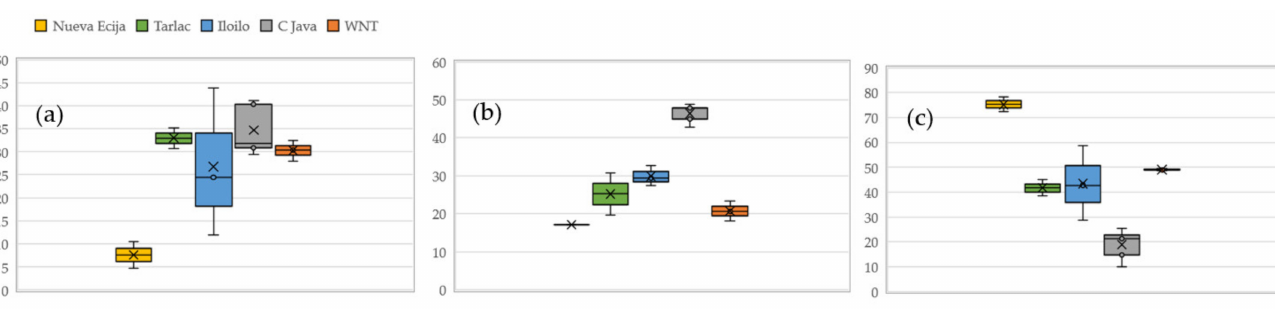
Figure 1. Characteristics of local weather in the target areas: ( a ) rainfall (mm), ( b ) minimum air temperature, ( c ) maximum air temperature and ( d ) wind speed. The x-axis shows the provinces in each country.